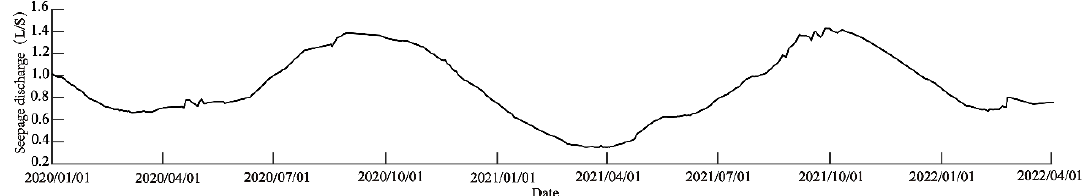
Figure 8. Process line of main water of seepage discharge at measuring point WE01XFG.